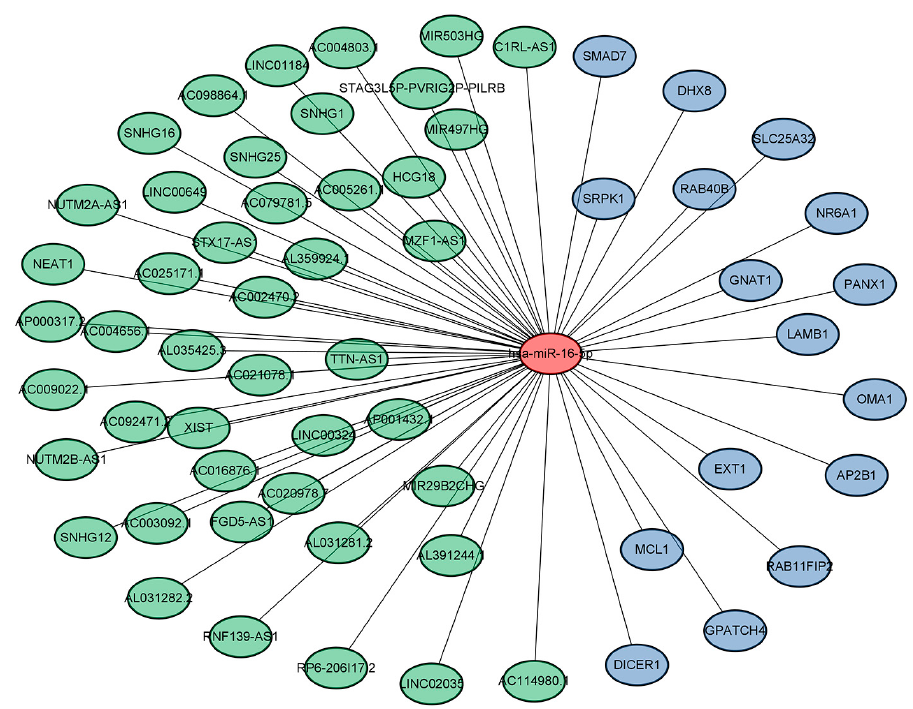
Figure 4. Results of pathway enrichment analysis (miR-16-5p). Table 3. Hub genes and their corresponding enriched pathways in the key subnetwork.